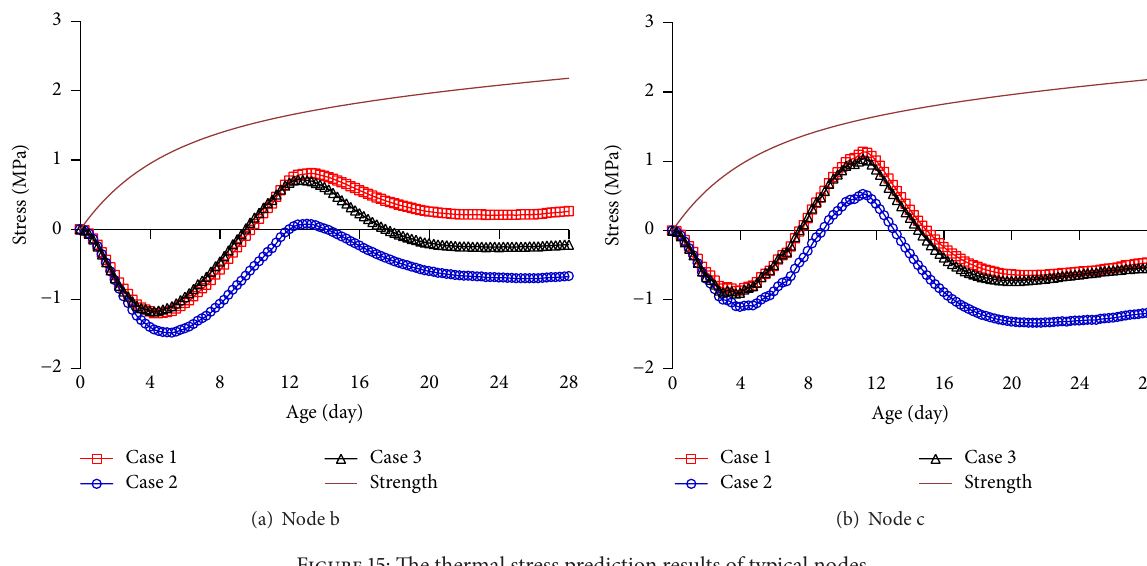
Figure 15: The thermal stress prediction results of typical nodes.